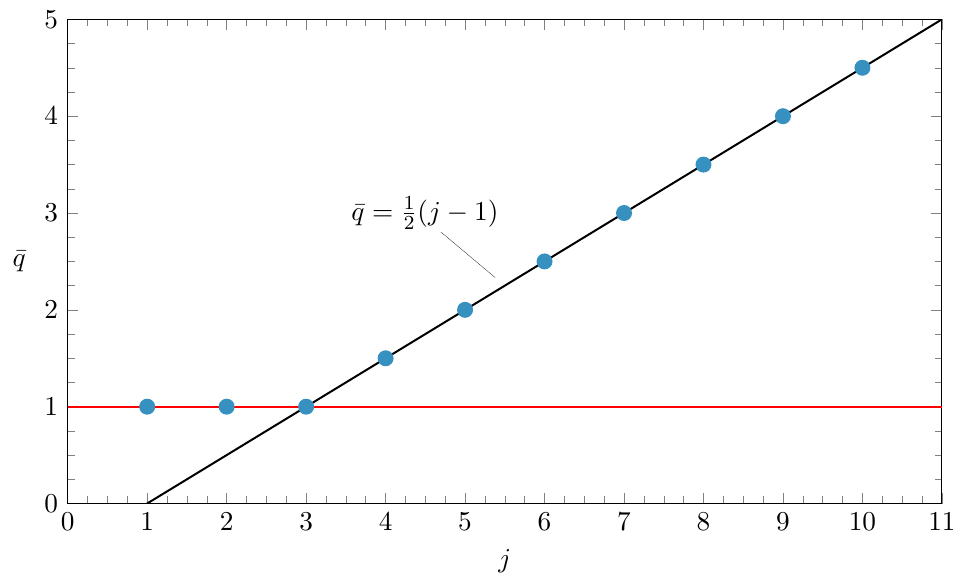
Figure 4 . Lower bounds on the conformal dimension as a result of the ANEC for [ A 1 ; L ] multiplets. Each point is the result of a bisection algorithm done with Mathematica . The operators for j 6 3 that lie on the red line satisfy [ A 1 ; A 2